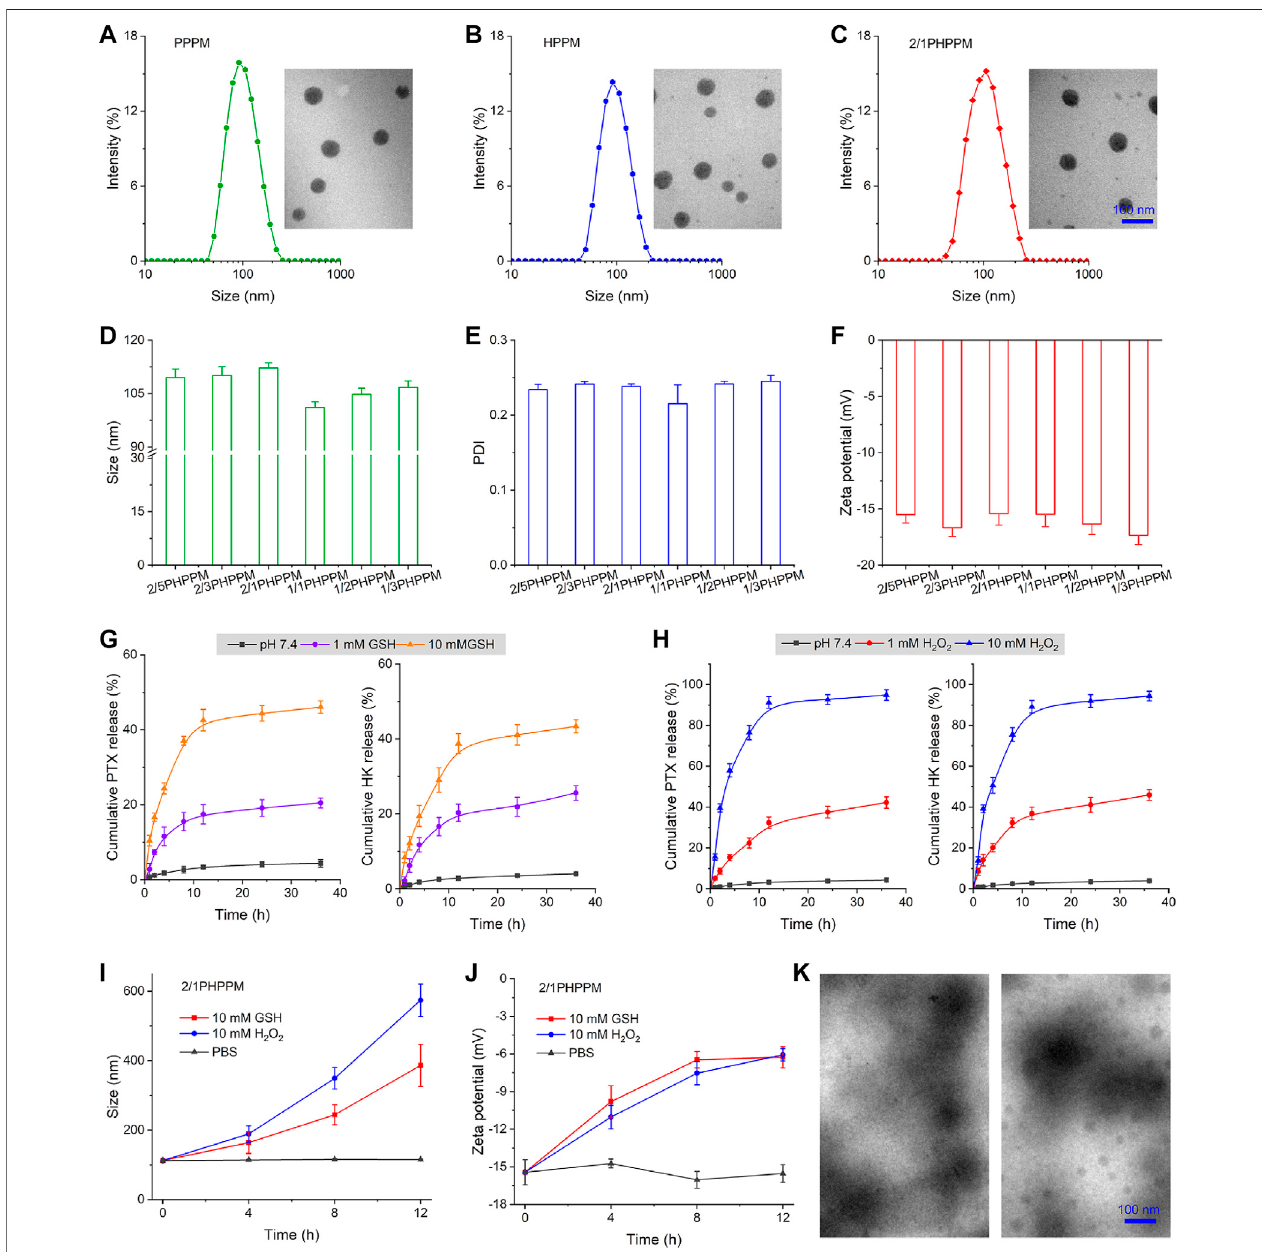
FIGURE 3 | Preparation and characterization of PPMs. (A – C) the hydrodynamic particle size and transmission electron microscopy (TEM) images of PPPM (A) , HPPM (B) , and 2/1PHPPM (C) . (D – F) Size (D) , polydispersity index (E) , and zeta potential (F) of PHPPMs with different polymeric paclitaxel (PTX) and honokiol (HK) ratios. (G – H) thecumulativereleaseofPTXandHKfrom2/1PHPPMinthepresenceofdifferentconcentrationsofglutathione(GSH) (G) orhydrogenperoxide(H 2 O 2 ) (H) . (I – J) the changes in size (I) and zeta potential (J) of 2/1HPPPM following incubation with 10 mM GSH or H 2 O 2 for 0, 4, 8, and 12 h. (K) transmission electron microscope images of 2/1HPPPM following incubation with 10 mM GSH or H 2 O 2 for 12 h. Data are represented as the mean ± standard deviation, n =